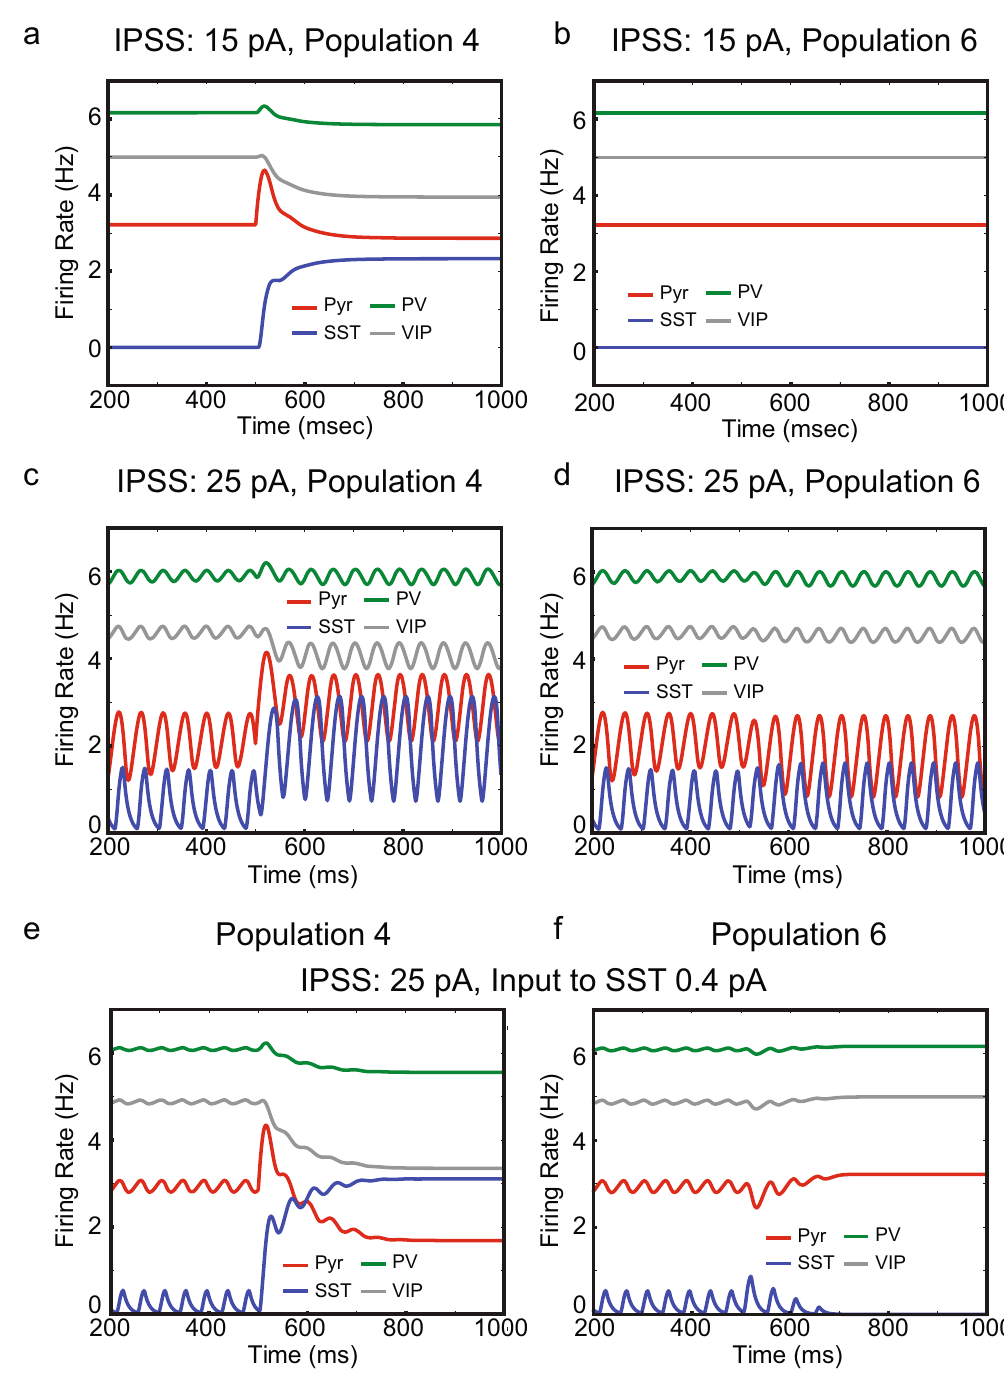
Figure 2. The effects of surround suppression on model responses. ( a and b ) Cell-type specific activity in populations 4 and 6, respectively, when the strength of IPPS is 15 pA. ( c and d ) The same but with enhanced IPPS strength (25 pA). ( e and f ) The same when the background input to SST cells and IPSS strength are 0.4 and 25 pA,